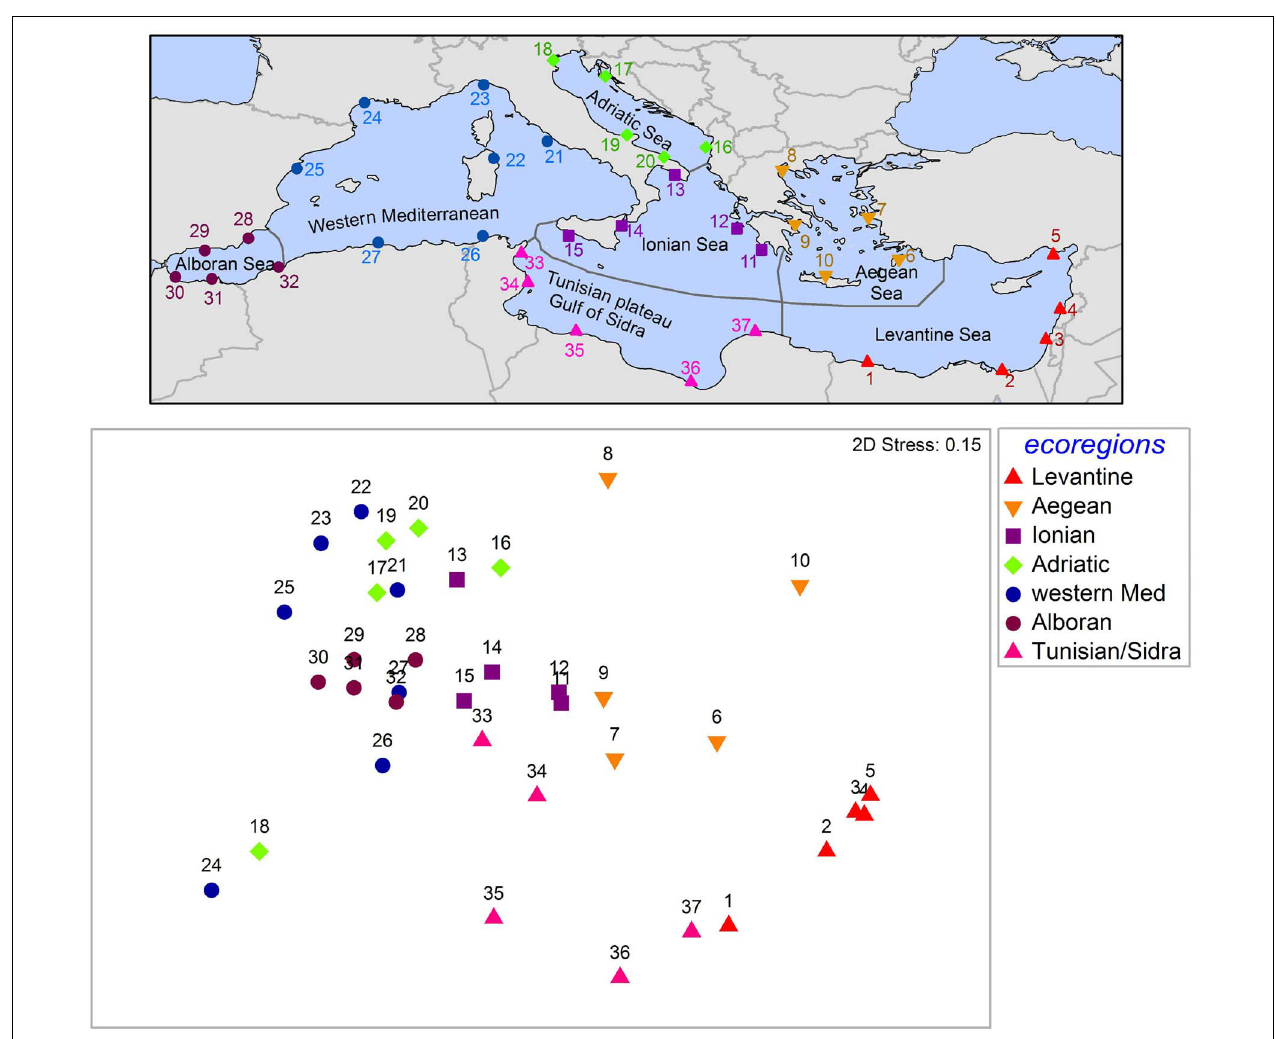
FIGURE 6 | Top panel: The 37 “sampling” sites in the seven Mediterranean ecoregions (sensu Spalding et al., 2007). Presence/ absence data for these sites were retrieved from EASIN. Site 18: